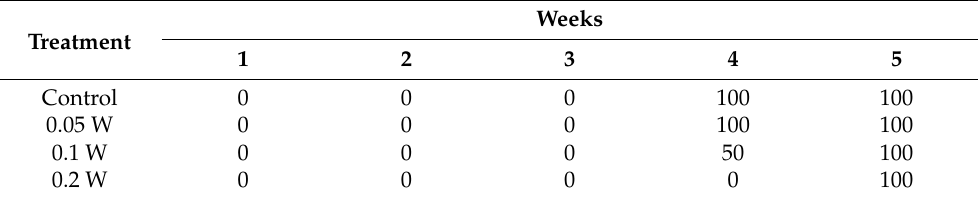
Figure 5. Appearance of a red perilla leaf at the 5th node counted from the bottom of the main stem 2 weeks after treatment initiation (Experiment 2). Perilla plants were irradiated for 3 h from 02:00 to 05:00 h in a UV-B light treatment regimen. The UV-B radiation intensity at the plant canopy level was set to 0.05, 0.1, or 0.2 W m − 2 . The integrated UV-B energy at 0.05, 0.1, and 0.2 W m − 2 was 0.54, 1.0, and 2.2 kJ m − 2 day − 1 , respectively. Leaves at the 5th node counted from the bottom of the main stem were harvested 2 weeks after treatment initiation. Leaf blade length under the control, 0.05 W, 0.1 W, and 0.2 W treatment conditions was 11.4 ± 0.8, 11.3 ± 0.4, 9.5 ± 0.4, and 7.1 ± 0.7 cm, respectively (mean ± SE, n = 4). Each white bar indicates 5 cm. Table 2. Weekly percentage flowering of red perilla (Experiment 2, n = 4). The weekly percentage flowering was determined by dividing the number of plants that formed flower buds by the number of plants tested. Perilla plants were irradiated for 3 h from 02:00 to 05:00 in all UV-B light treatments. The UV-B radiation intensity at the plant canopy level was set to 0.05, 0.1, or 0.2 W m −2 . Treatment